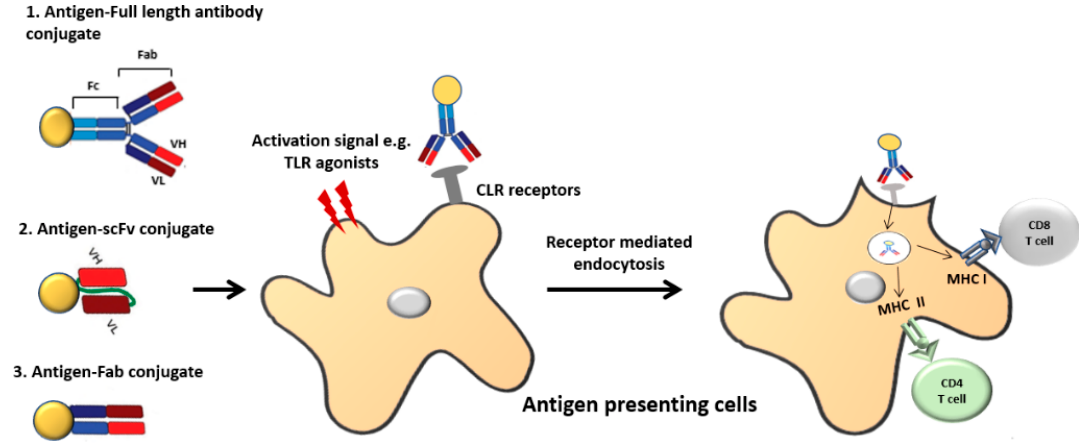
Figure 2. Illustration of antibody-based antigen targeting. The full antibody or antibody fragments such as Fab (fragment antigen binding), scFv (single chain fragment variable antibody) can be conjugated to the antigen chemically or recombinantly. In most cases, C-type lectin receptors (CLR) have been targeted for this purpose. Dendritic cell (DC) activation signals like Toll-like receptor (TLR) agonists are often required for protective immunity. Once the antigen–antibody complex binds to the respective receptor on antigen presenting cells, it undergoes receptor mediated endocytosis and is presented either via the MHC I or MHC II pathway.